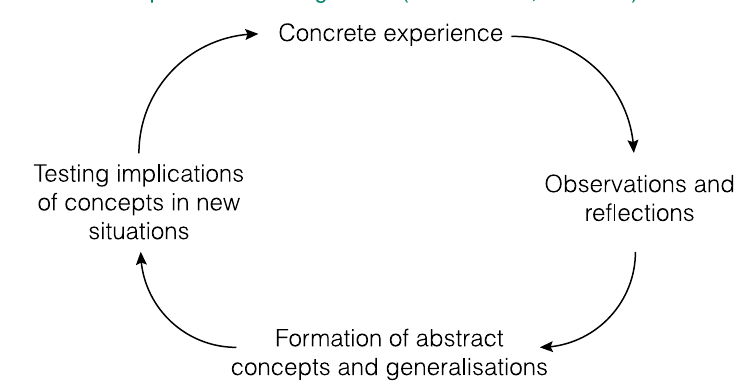
Figure 1: lewin’s experiential learning model (cited in Kolb, 1984: 21).